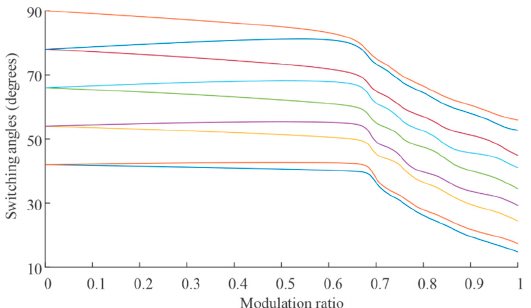
Figure 3. Switching angle trajectories when N = 9.